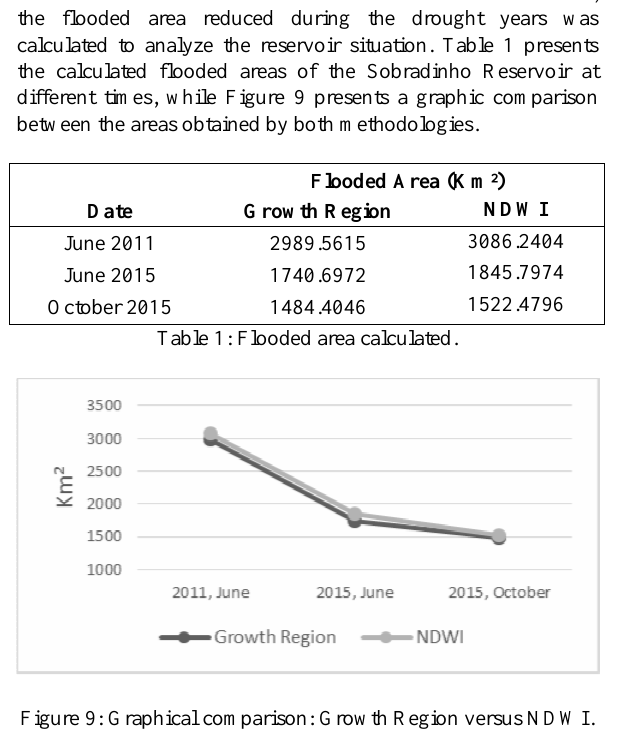
Figure 9: Graphical comparison: Growth Region versus